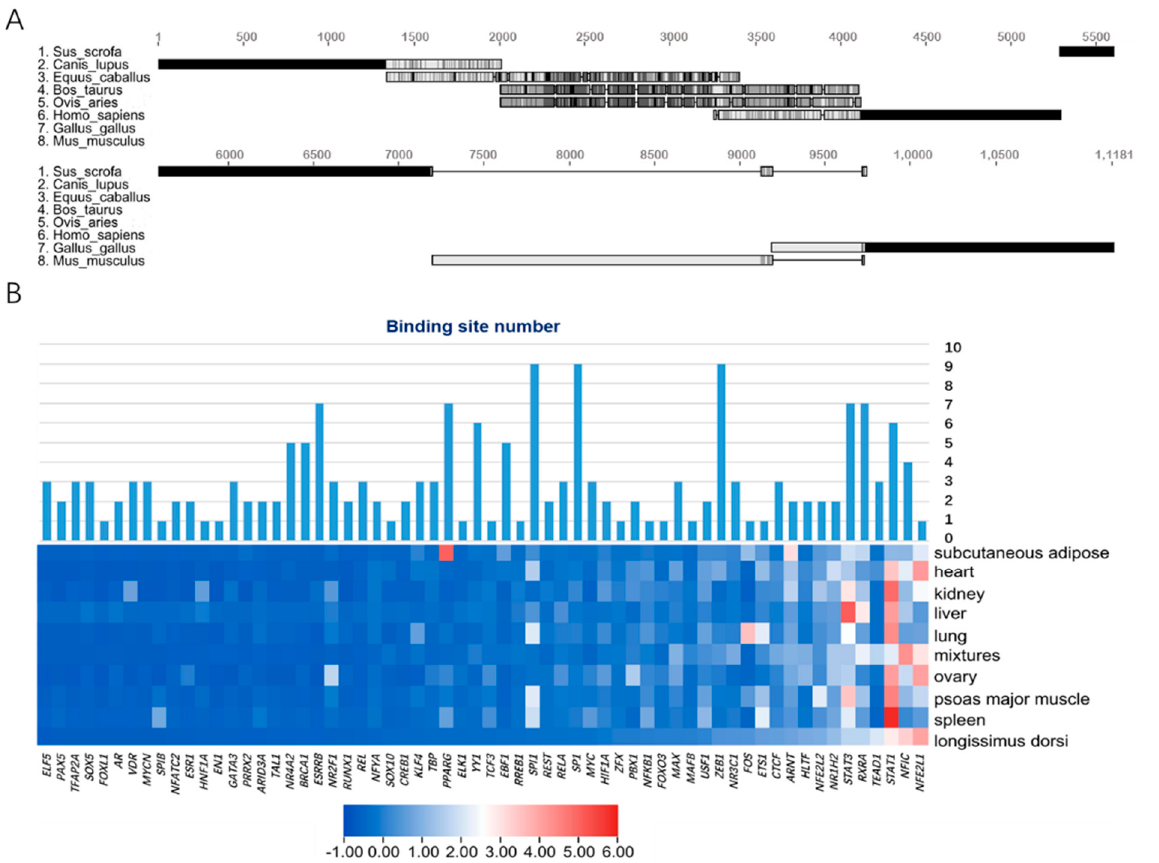
Figure 2. Prediction and enrichment of transcription factors of porcine Mb gene. ( A ) multiple sequence alignment of promoters (2 kb) of Mb gene in 8 representative mammals; ( B ) heatmap of 62 TFs expression in 9 tissues of pig with binding sites integrated.